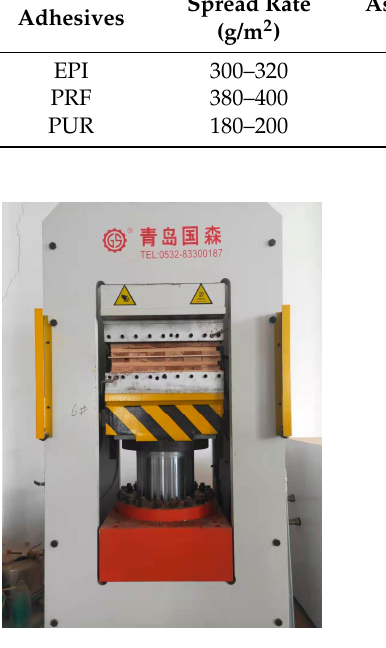
Figure 1. Image of cross-laminated timber (CLT) manufactured by press in the lab. Table 1. Gluing process parameters.